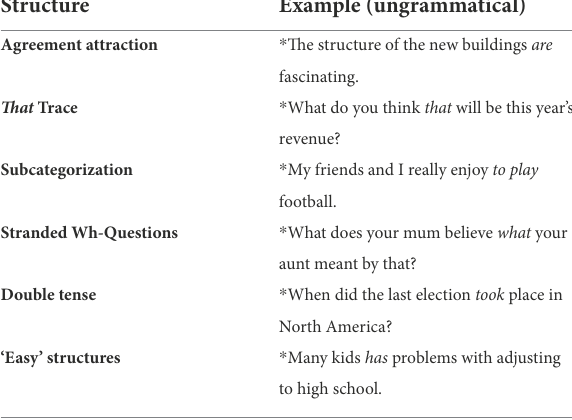
TABLE 2 Examples of morphosyntactic structures used in the English GJT.